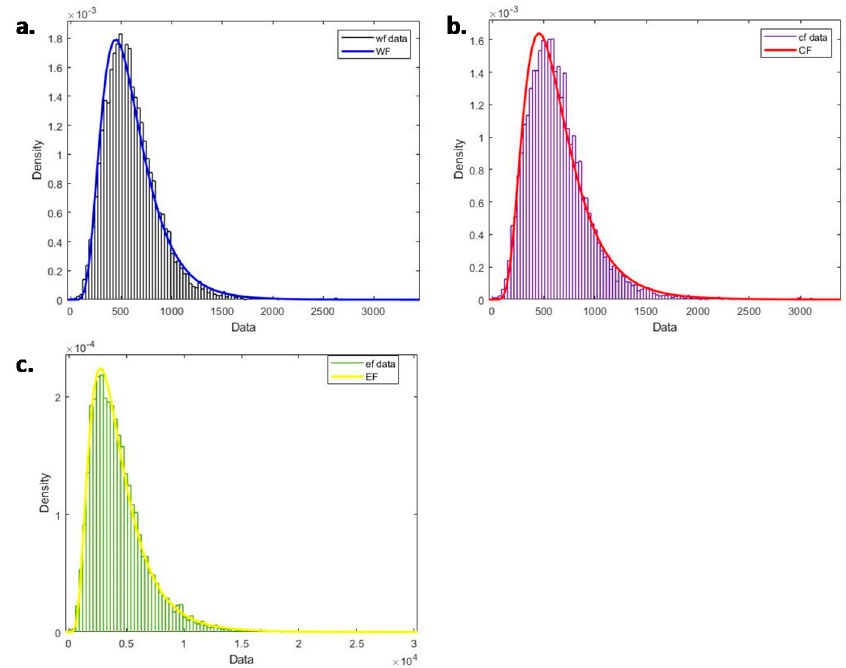
Figure 4. Distribution bar charts for environmental footprint consumption where ( a ) shows water footprint, ( b ) shows carbon footprint, and ( c ) shows ecological footprint .